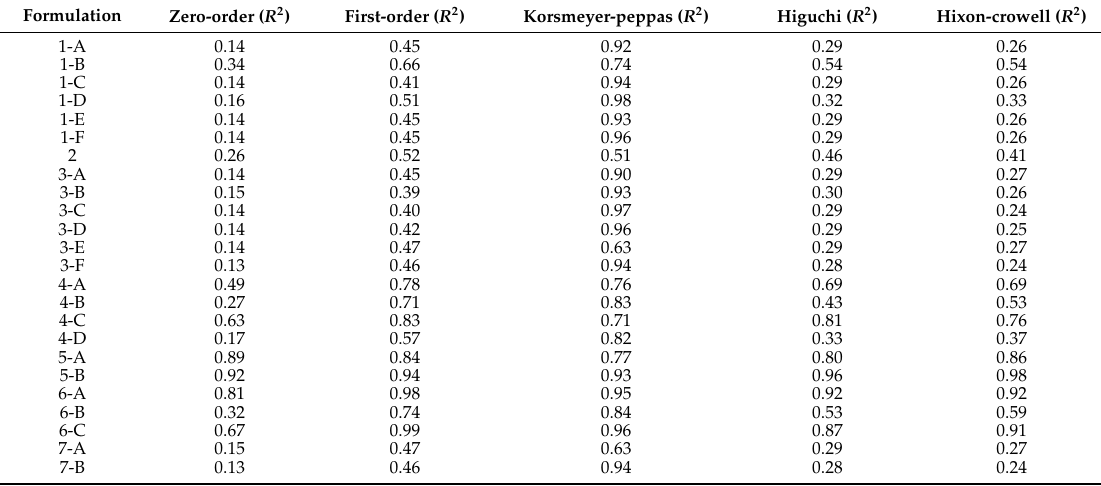
Table A1. The amount of vancomycin was plotted against time on the x -axis. Individual replicates of each formulation, indicated by the letter, were then fitted to each of the common pharmacokinetic models to identify the best fit according to R 2